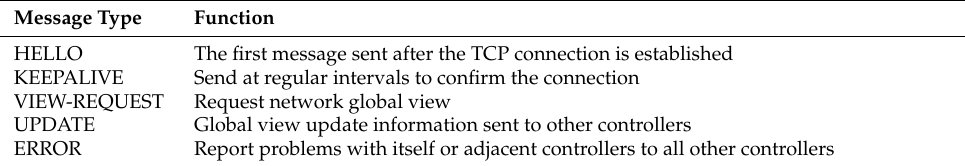
Table 2. Message type table for information